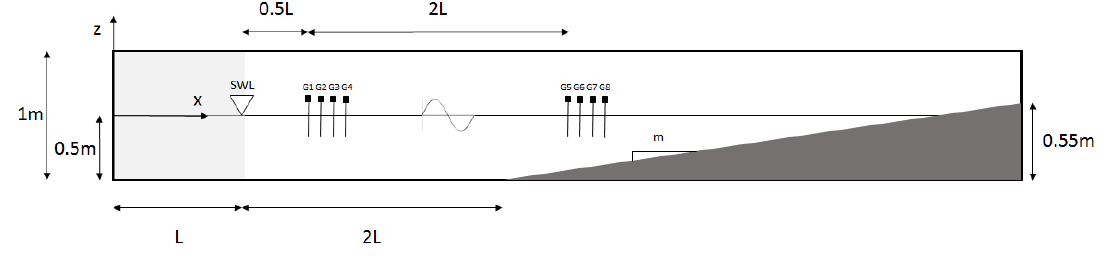
Figure 12. NWT used for